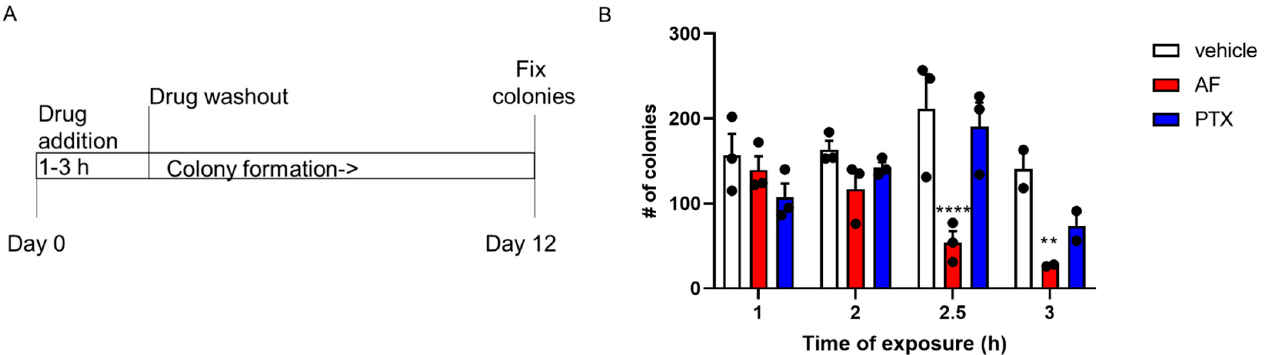
Figure 3. Taccalonolide AF has potent and persistent effects in ovarian cancer cells following acute exposure. ( A ) Persistence assay timeline. ( B ) Colony formation of SK-OV-3 cells after treatment with 50 nM paclitaxel (PTX) or taccalonolide AF compared to vehicle for 1–3 h (n = 2–3 independent experiments) before cells were washed and replaced with fresh media lacking drug. Closed circles represent individual data points. Statistical significance determined by two-way ANOVA with Dunnett’s post hoc test for multiple comparisons with significance compared to vehicle shown. **** p < 0.0001 and ** p = 0.0098.